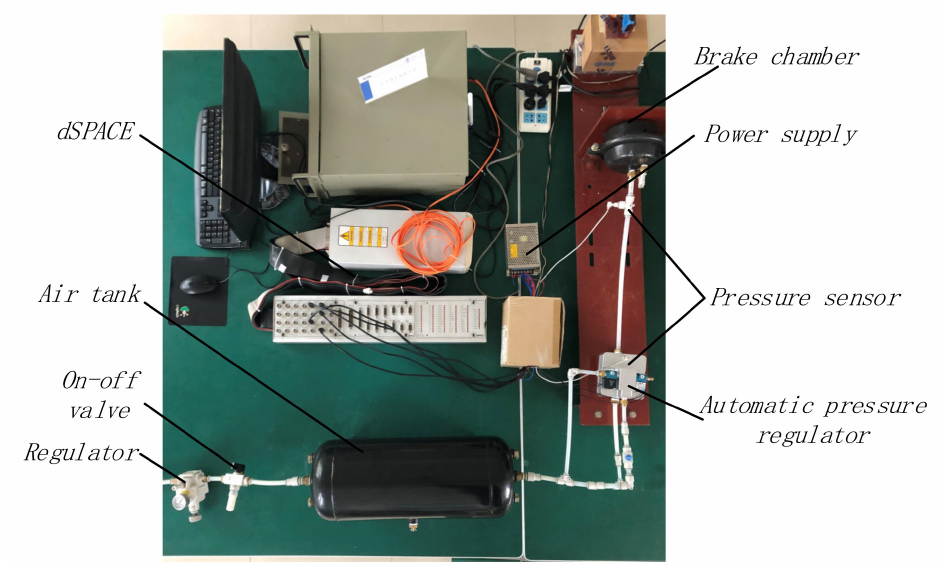
Figure 7. Hardware in the loop test bench for an automatic pressure regulating valve. 1. With the expected pressure set to 0.5 MPa, the pressure response and the pressure